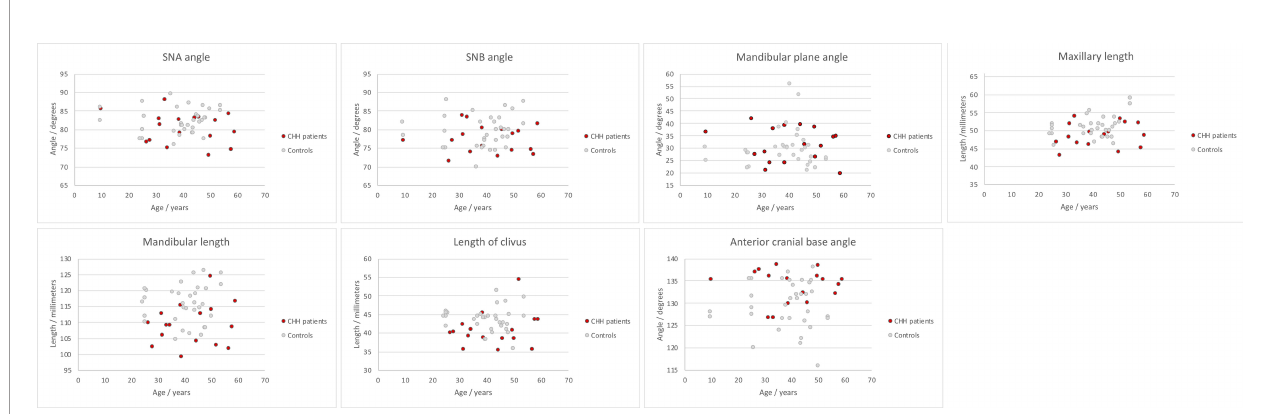
FIGURE 2 | Distribution of cephalometric measurements in patients with Cartilage-hair hypoplasia (CHH) and heathy